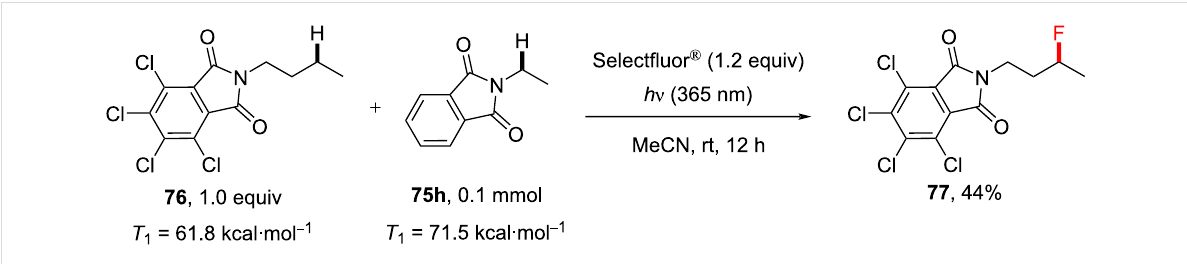
Scheme 33: Substrate crossover monofluorination experiment.